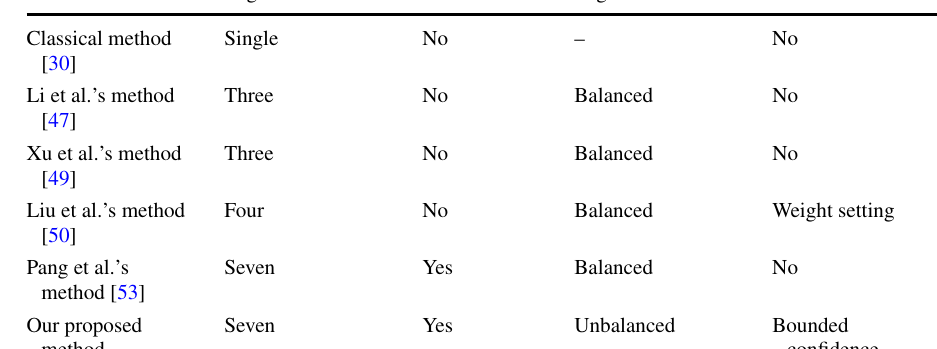
Table 14 Characteristics of various decision-making methods